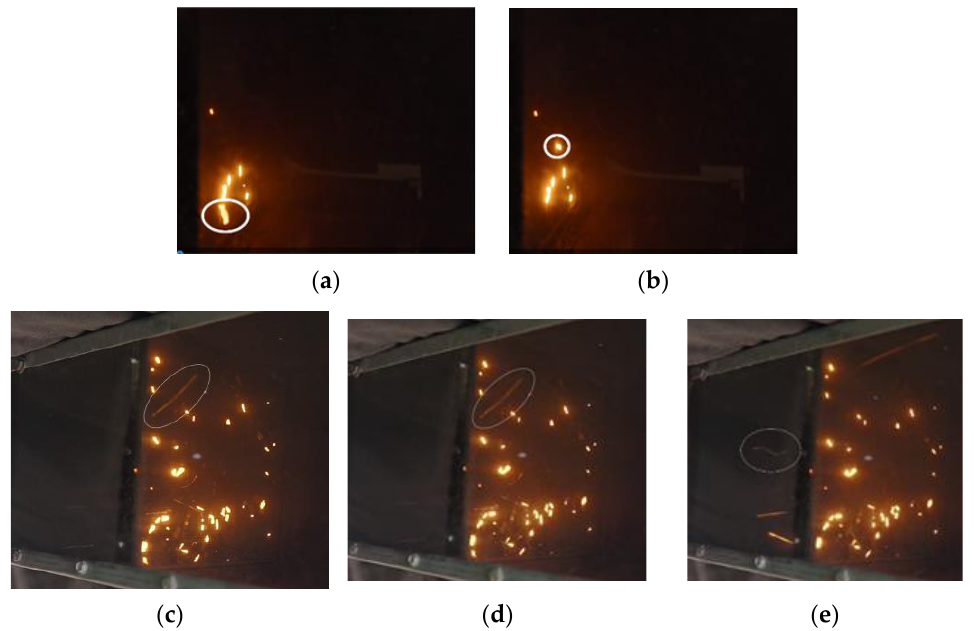
Figure 14. The slipping firebrands, ( a ) a firebrand at hitting point, ( b ) the firebrand slipped and changed and became a pausing firebrand, ( c ) an approaching firebrand, ( d ) the slippage of the firebrand, ( e ) the firebrand became quenched at its new location and passed (stopping firebrand) (Stainless Steel Wire and Mesh Pty Ltd. [17]).